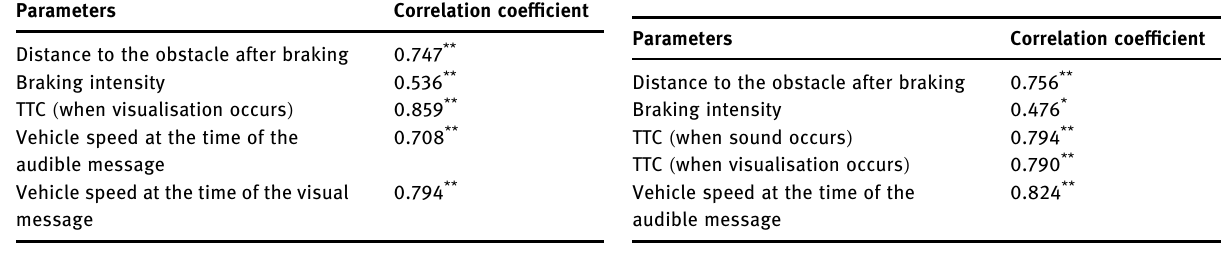
Table 15: Correlation of vehicle speed at the time of the visual message with the rest of the parameters Parameters Correlation coe ffi